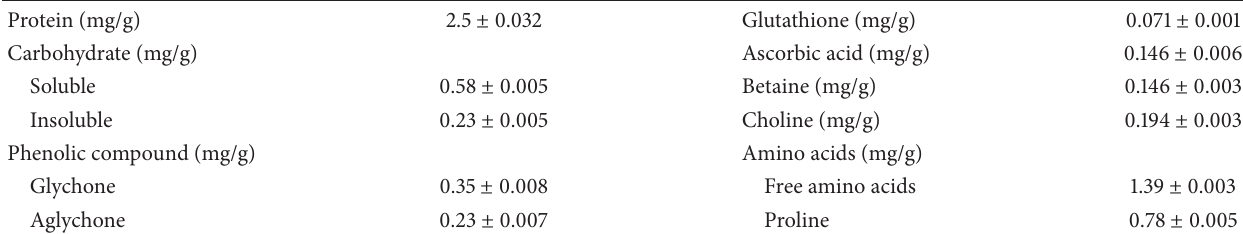
Table 5: Some biochemical analyses of marine alga Ulva lactuca